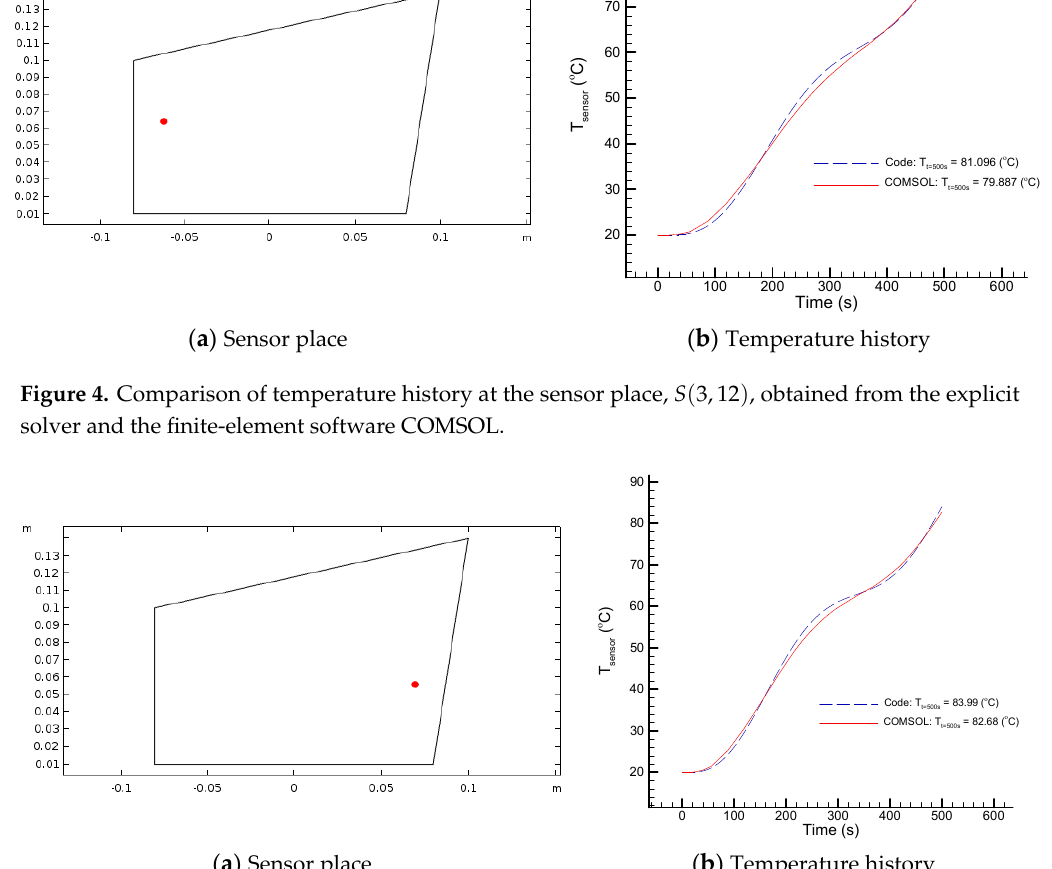
Figure 5. Comparison of temperature history at the sensor place, S ( 18,8 ) , obtained from the explicit solver and the finite-element software COMSOL.